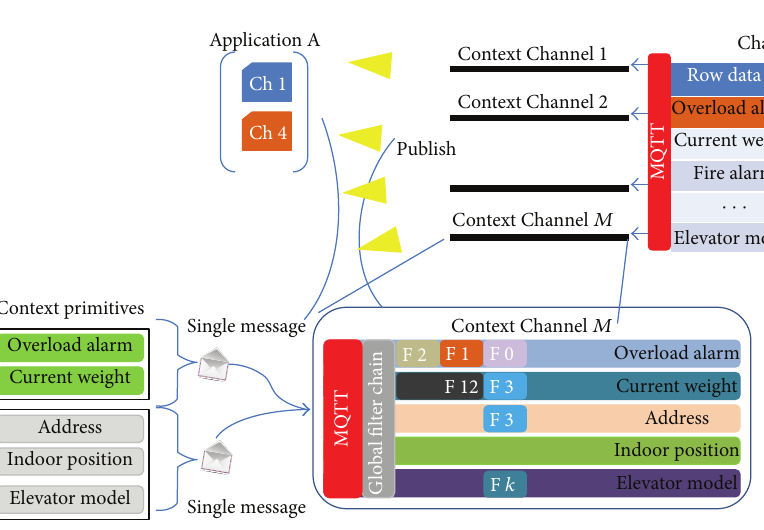
Figure 1: Overall structure of SCondi.